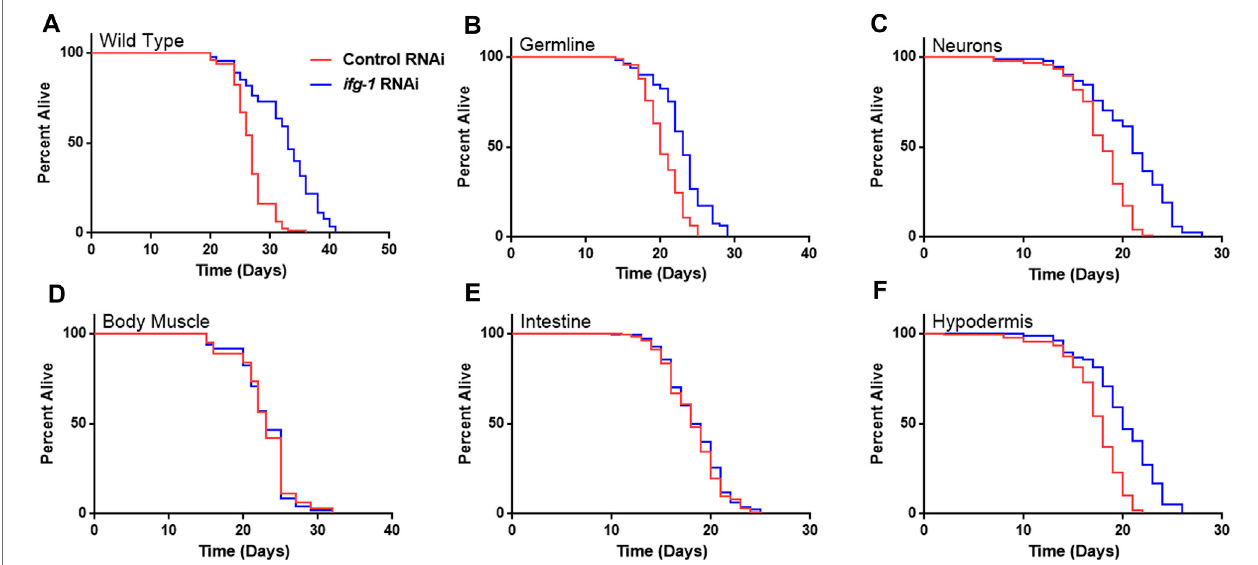
FIGURE 1 | Reducing CBC-mediated translation selectively in germ cells, neurons or hypodermis extends lifespan. Bacteria expressing control or ifg-1 dsRNA were fed to animals beginning at day 1 of adulthood in A-F. (A) Median lifespan in the wild-type N2 strain increased by 22.2% compared to control ( p < 0.0001). (B) Median lifespan in the MAH23 germline-speci fi c RNAi strain increased by 15.0% compared to control ( p < 0.0001). (C) Median lifespan in the TU3335 neuronal-speci fi c RNAi strain increased by 16.7% compared to control ( p < 0.0001). (D) Median lifespan in the WM118 body muscle-speci fi c RNAi strain was not signi fi cantly changed ( p (cid:1) 0.98). (E) Median lifespan in the VP303 intestine-speci fi c RNAi was not signi fi cantly changed ( p (cid:1) 0.47). (F) Median lifespan in the NR222 hypodermis- speci fi c RNAi strain increased by 11.1% compared to control ( p < 0.0001). Kaplan – Meier survival curves were compared using the Mantel – Cox log-rank test. See Supplementary Table S1 for additional details and